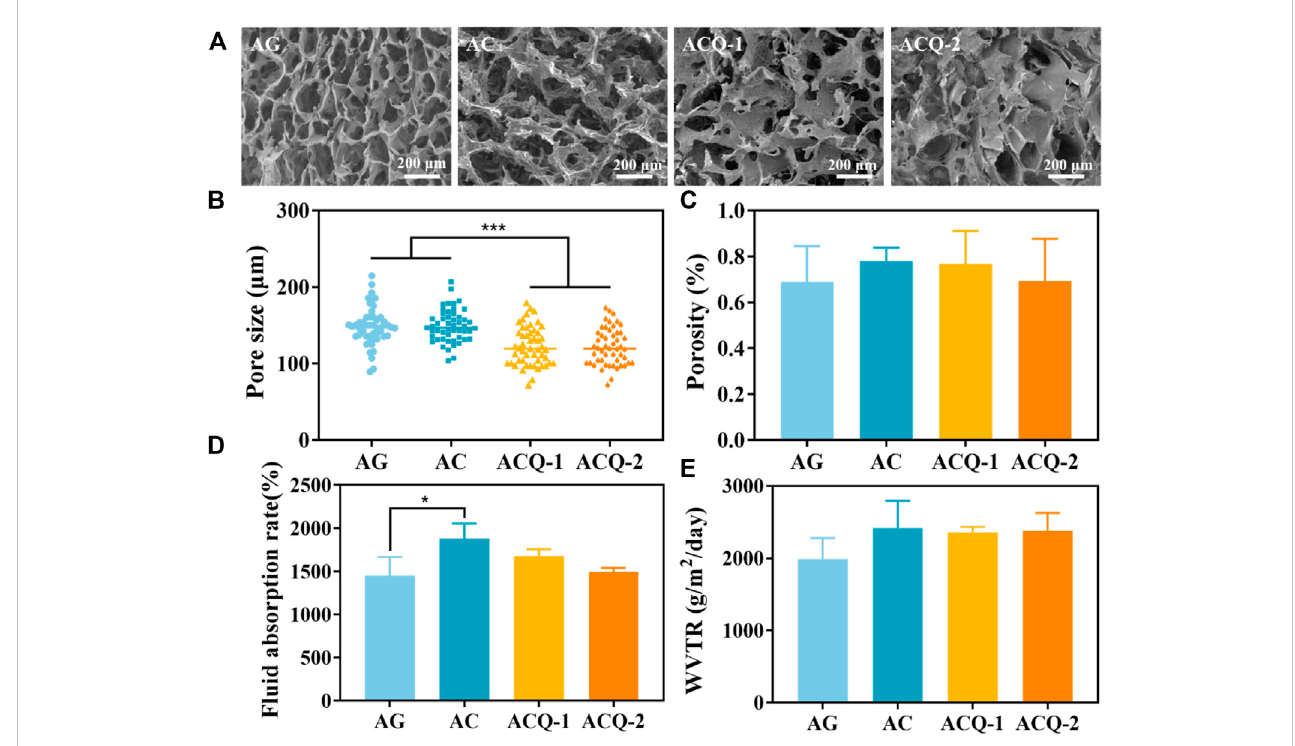
FIGURE 3 (A) SEM images of AG, AC, ACQ-1, and ACQ-2 sponges at ×100 magni fi cations, respectively. (B) Pore size, (C) porosity, (D) fl uid absorption rate, and (E) WVTR of various sponges. Data are mean ± SD (n = 3) (* p < 0.05, *** p < 0.001).